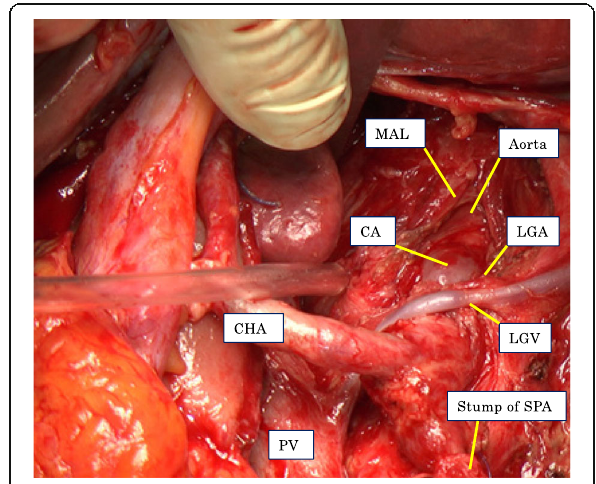
Fig. 3 Intraoperative demonstration of median arcuate ligament